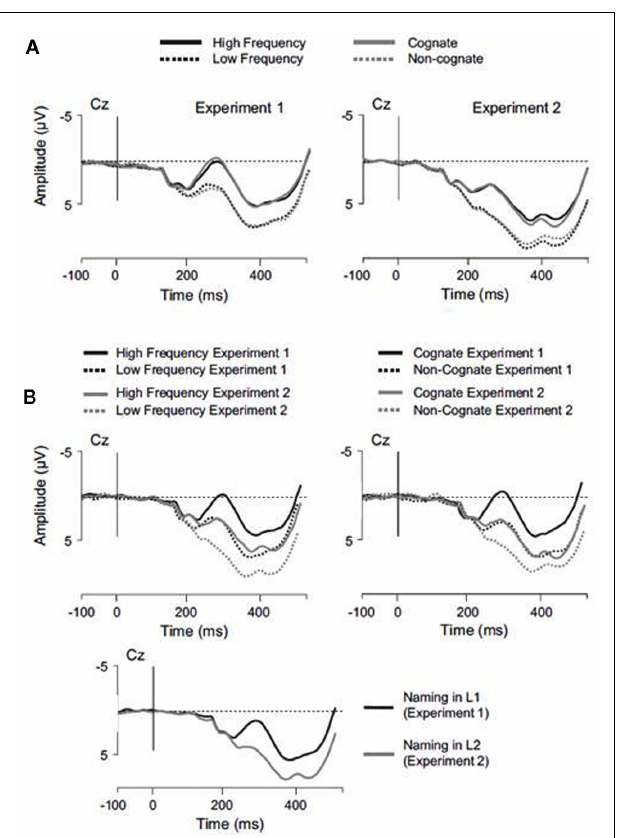
FIGURE 2 | Figure taken from Strijkers et al. (2010). (A) Shows low-frequency and high-frequency ERPs compared with non-cognate and cognate ERPs at Cz in Experiment 1 (right) and Experiment 2 (left).The frequency ERPs are represented by a full gray and black line.The cognate ERPs are represented by a dotted gray and black line. Negativity is plotted upward. (B) Shows a between experiments comparison of the low- and high-frequency ERPs (left), non-cognate and cognate ERPs (right), and overall naming in L1 and naming in L2 ERPs (under). Negativity is plotted